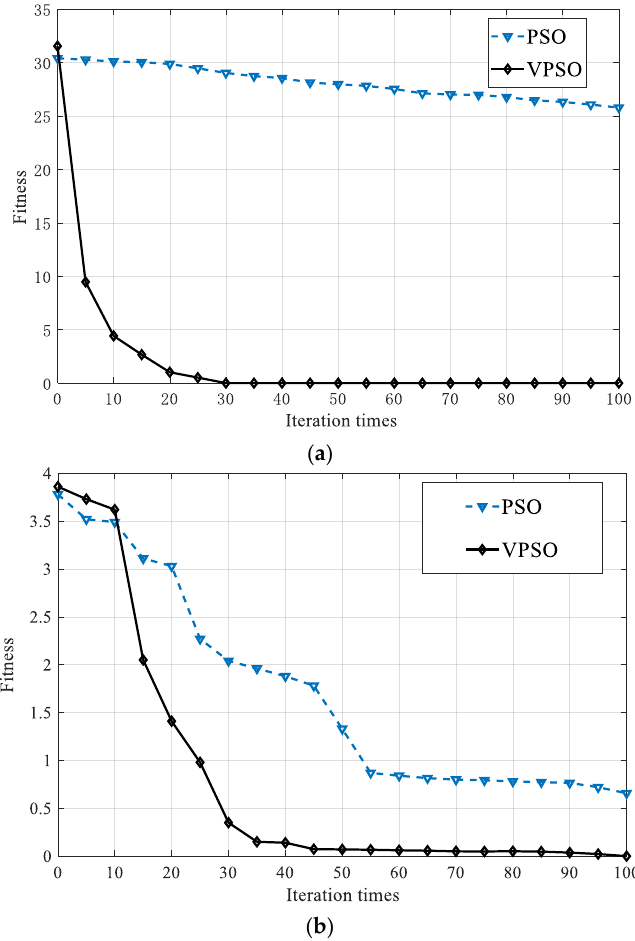
Table 3. The minimum fitness of the two algorithms.